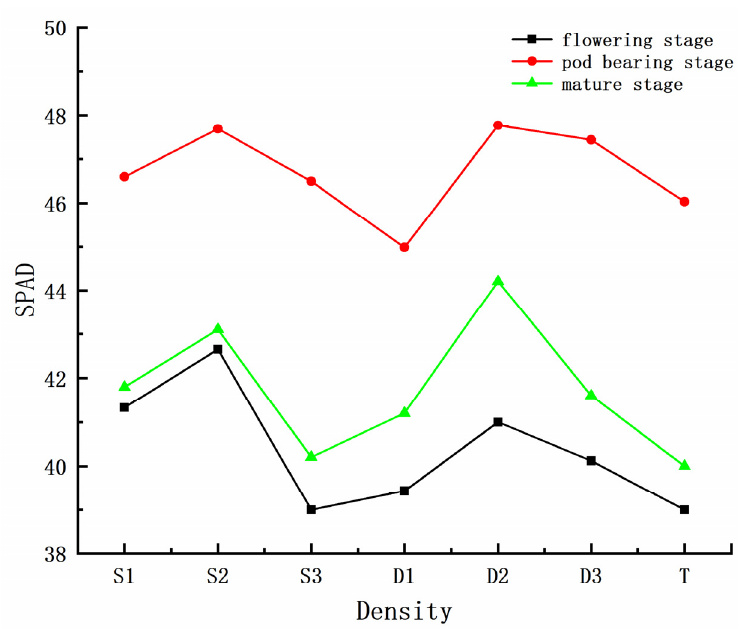
Figure 3. Chlorophyll content of peanuts at different growth stages under different plant